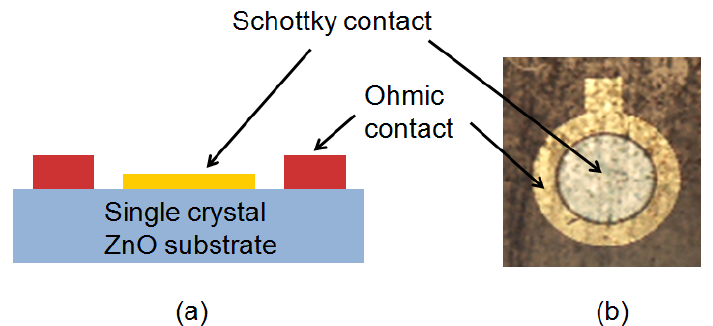
Figure 1. (Color Online) Simplified schematic illustration of the Pd / ZnO Schottky Barrier Diode (SBD): ( a ) Cross sectional view, ( b ) Top view (optical microscope image). Pd and Ti / Al / Pt / Au are used as Schottky and ohmic contacts, respectively.